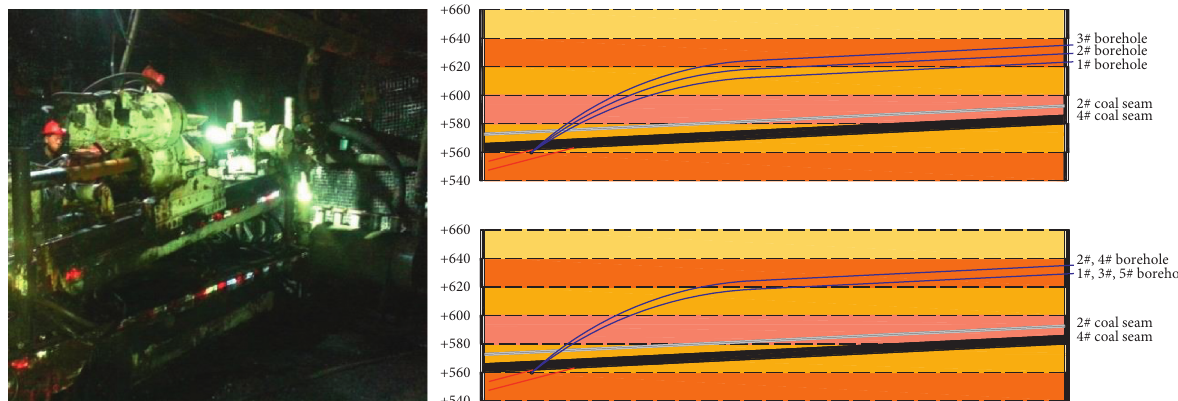
Figure 17: Site construction and trajectory of long-hole directional drilling in the fracture zone in overlying strata of the 4305 rear working face.